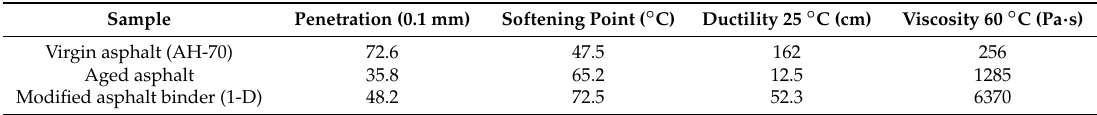
Table 1. Basic properties of virgin, aged and modified asphalt binder.